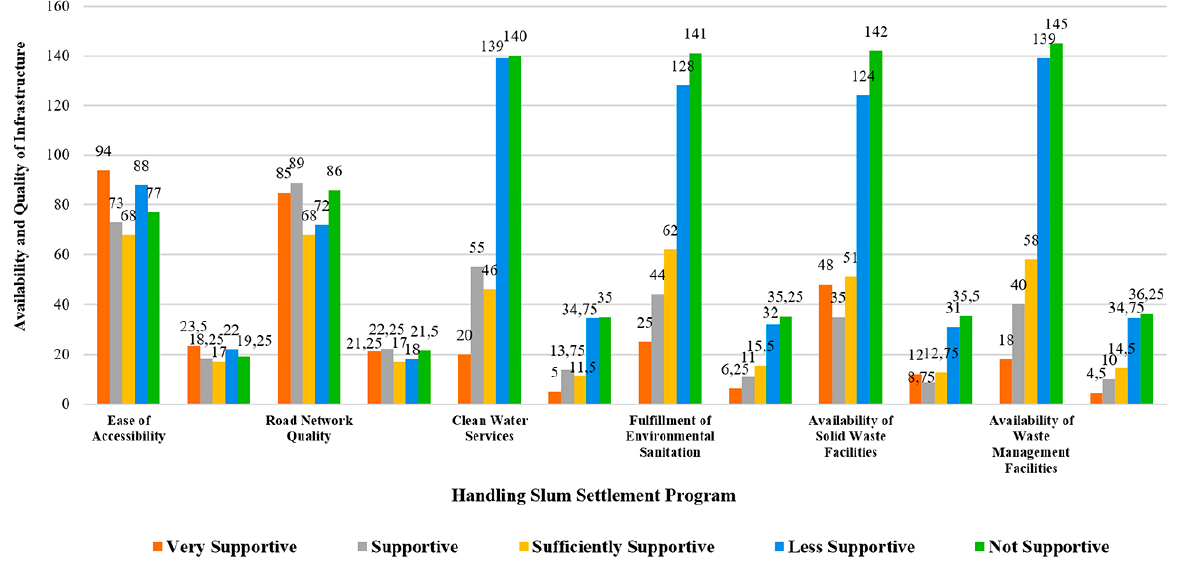
Figure 4. Quality and availability of slum settlement